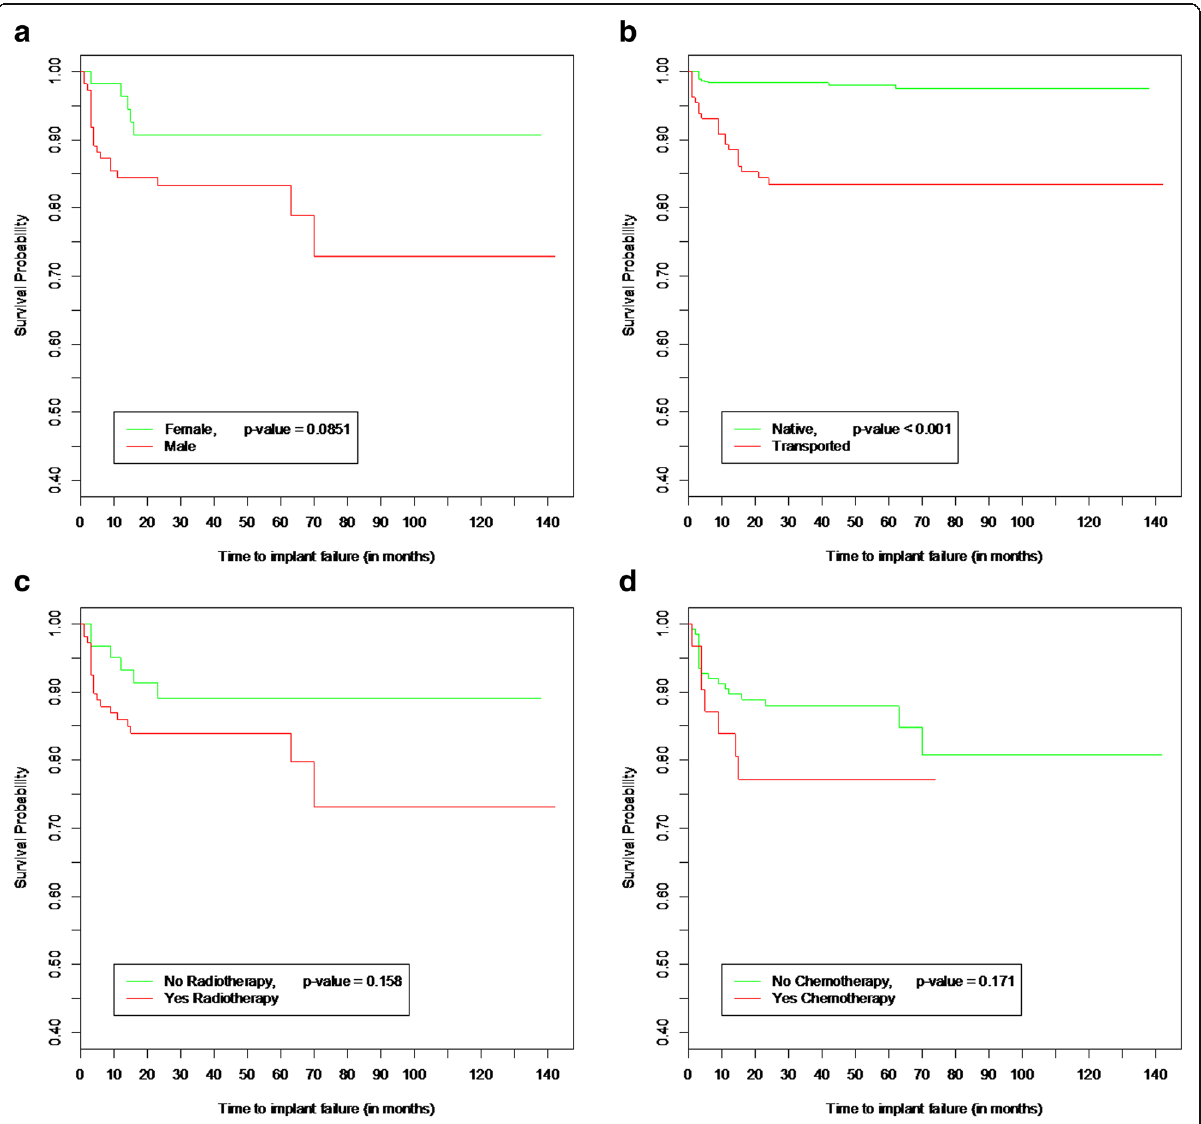
Fig. 3 a Kaplan-Meier survival curves comparing implant survival according to gender. Implants placed into males had higher failure rate in comparison to those placed into females; however, this was not found to be statistically significant ( p =0.09). b Kaplan-Meier survival curves comparing implant survival in the native and transported bone. Implants placed into the transported bone had higher implant failure rate in comparison to implants placed into the native bone. This was found to be statistically significant ( p ≤ 0.001). c Kaplan-Meier survival curves comparing implant survival in patients who received radiotherapy with those that did not. Implants placed into patients who received radiotherapy had a higher implant failure rate in comparison to implants placed into those patients who did not; however, this was not found to be statistically significant ( p =0.16). d Kaplan-Meier survival curves comparing implant survival in patients who received chemotherapy with those that did not. Implants placed into patients who received chemotherapy had a higher implant failure rate in comparison to implants placed into those patients who did not; however, this was not found to be statistically significant ( p